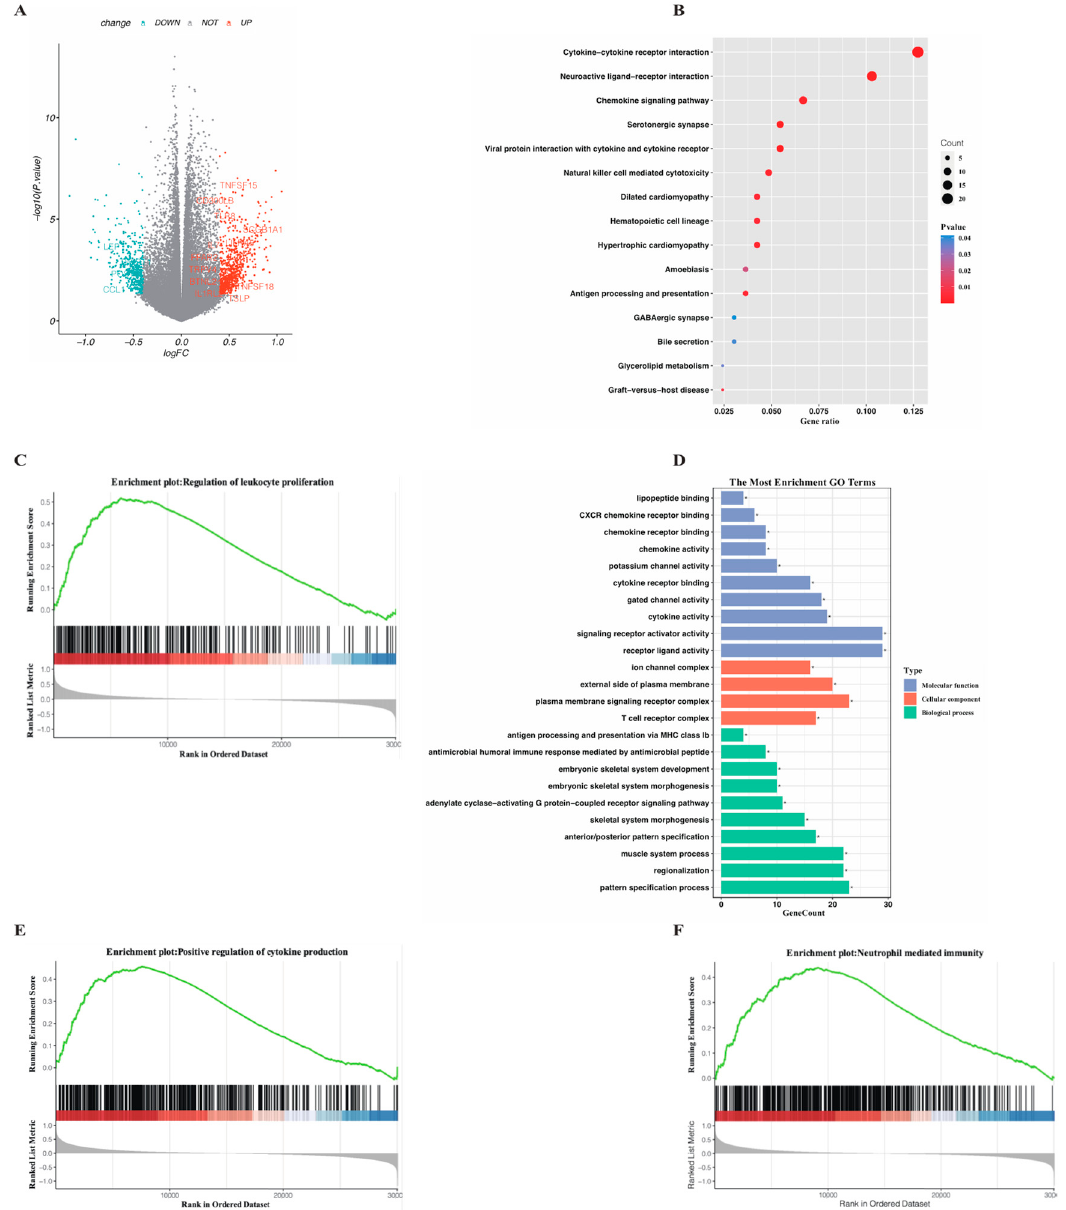
Figure 6. Functional enrichment analysis performed on the DEGs identified between the two risk subgroups in TCGA cohort. ( A ) Volcano plot displaying DEGs between the two risk subgroups by the threshold of |log2FC| ≥ 0.4 and adjusted p -value < 0.01. Specific DEGs involved in the selected pathways are displayed. ( B ) KEGG pathways significantly enriched in the high-risk group in the bubble plot form. ( C , E , F ) Selected canonical biological process associated GSEA pathways in the high-risk group. ( D ) Representative GO terms enriched in terms of biological process (BP), cellular component (CC) and molecular function (MF) respectively in the high-risk group. p value is showed as: * p < 0.05 .